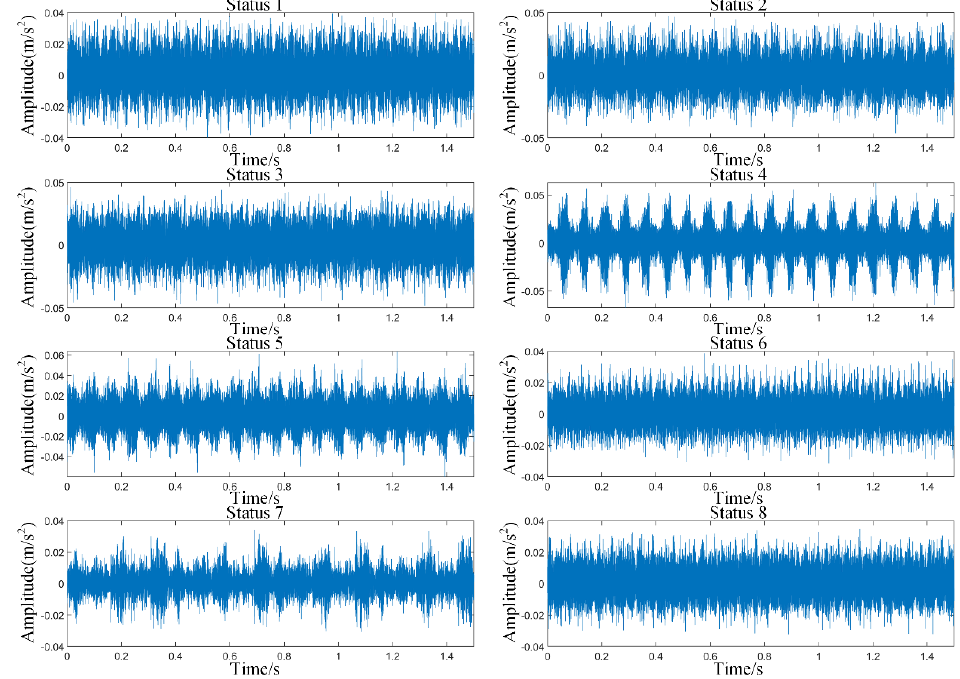
Figure 8. Waveforms corresponding to different states.